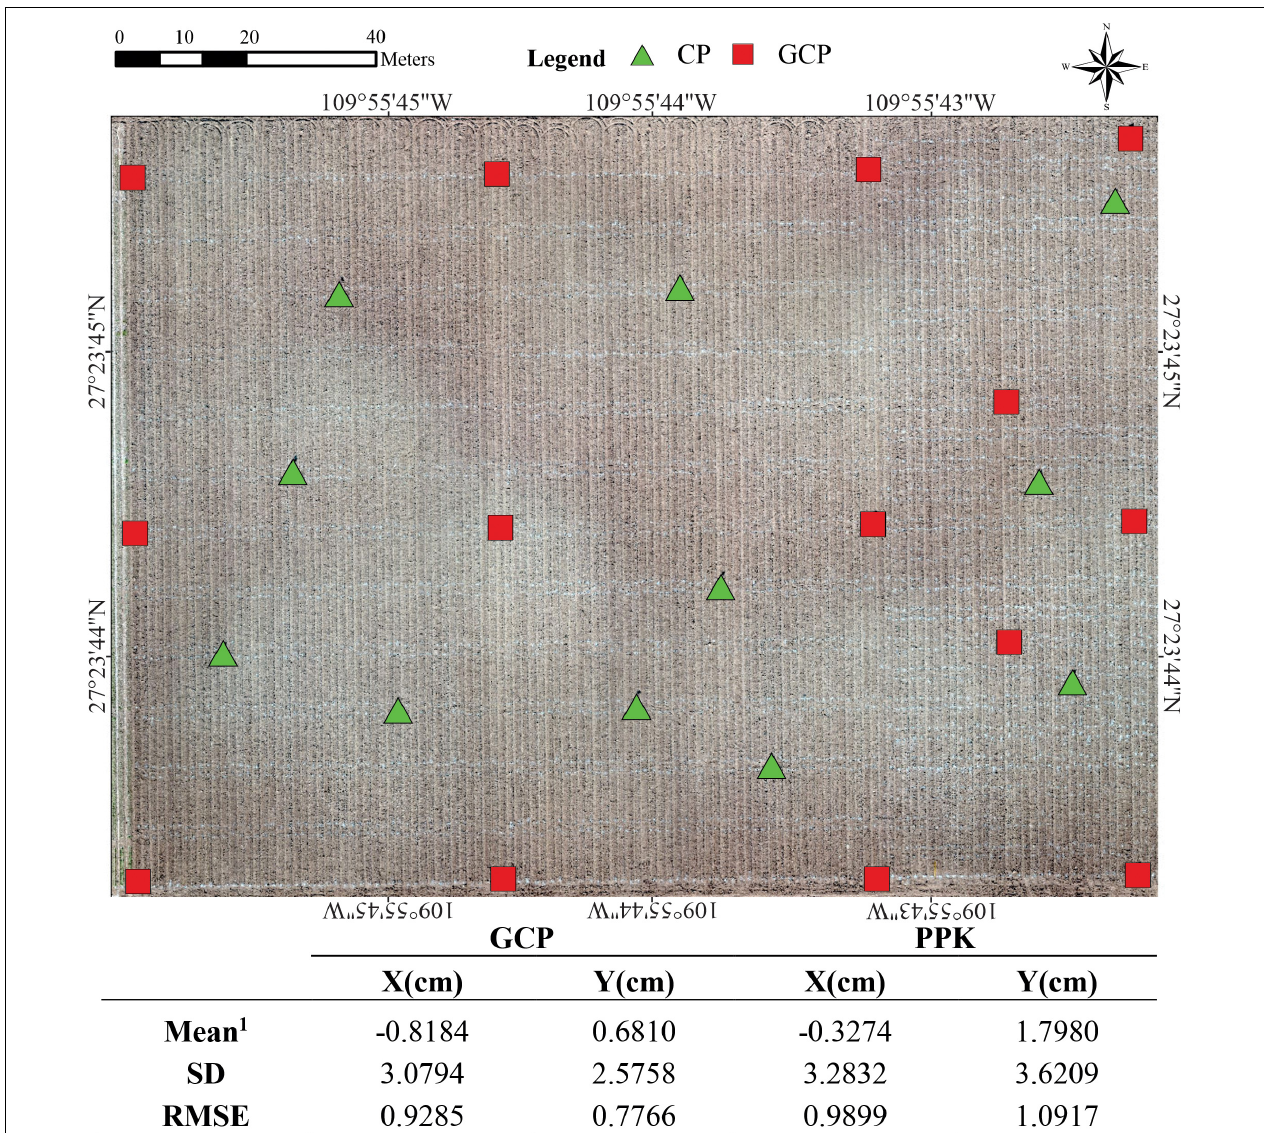
FIGURE 2 | The mean delta-X and delta-Y from all geocoordinates obtained from 11 checkpoints (CP) vs. the geocoordinates obtained from the orthomosaic (CSM) resulted from 14 GCP and PPK corrections. Standard deviation (SD) and Root Mean Square Error (RMSE) for X and Y coordinates. The base image corresponds to the bare soil flight using Plat FW in the HiBAP-II trial during November 2018. 1 Mean difference between measured coordinates to GCP and